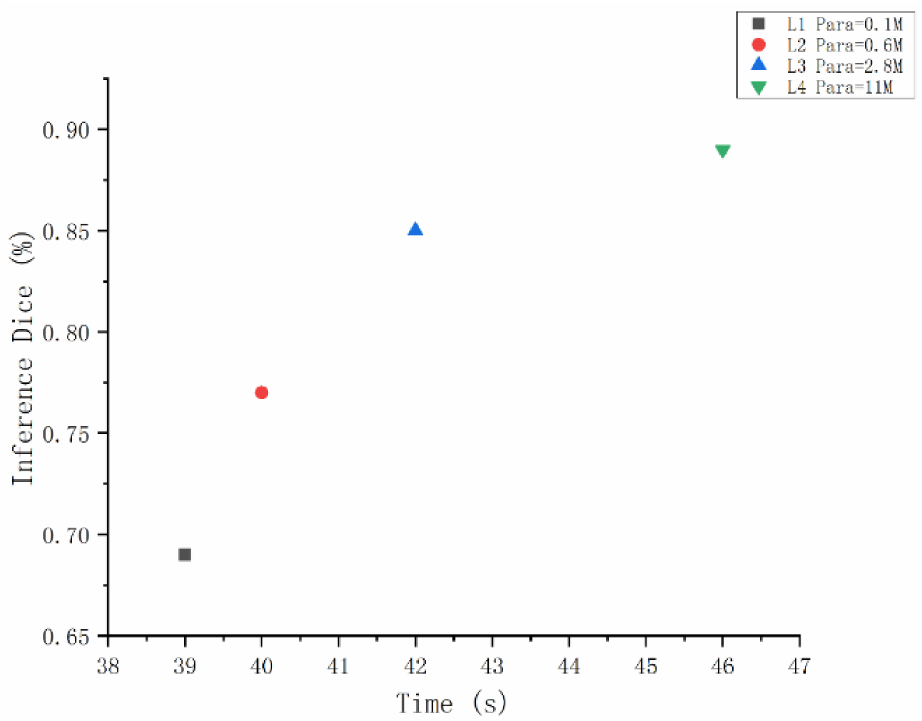
Figure 17. Inference time, dice coefficient and parameters of Residual-Attention UNet++ L 1 ∼ 4 for the skin cancer